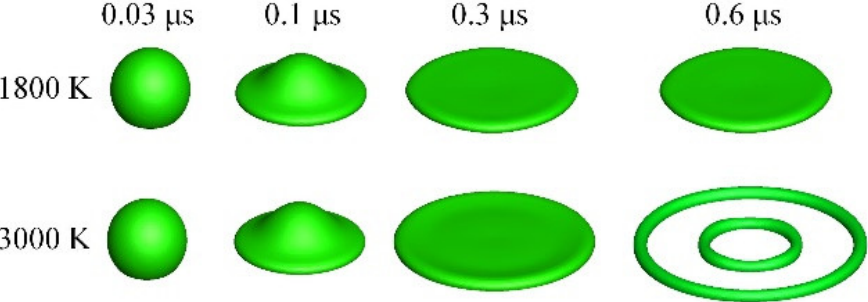
Figure 6. Solidification arresting Ni drop spreading.